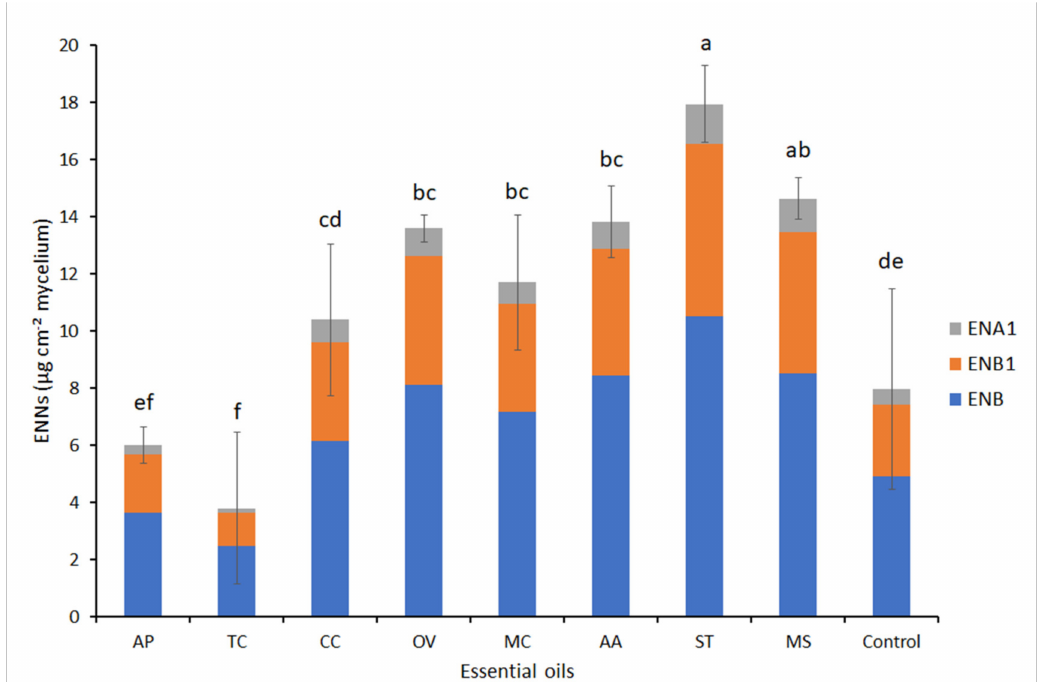
Figure 6. Effect of essential oils (EO) extracted from eight Tunisian plants, diluted at 0.1 µ L mL − 1 FDM-agar, on the production of enniatins by F. acuminatum 33T. Values are means of triplicates. Error bars are ± standard deviation. Means with the same lowercase letters are not significantly different ( p < 0.05). ENB1 = Enniatin B1, ENB = Enniatin B, ENA1= Enniatin A1, ENA = Enniatin A. AP = Ammoides pusilla , TC = Thymus capitatus , CC = Carum carvi , OV = Origanum vulgare , MC = Myrtus communis , AA = Artemisia absintum , ST = Schinus terbentofonius , MS = Mentha spicata